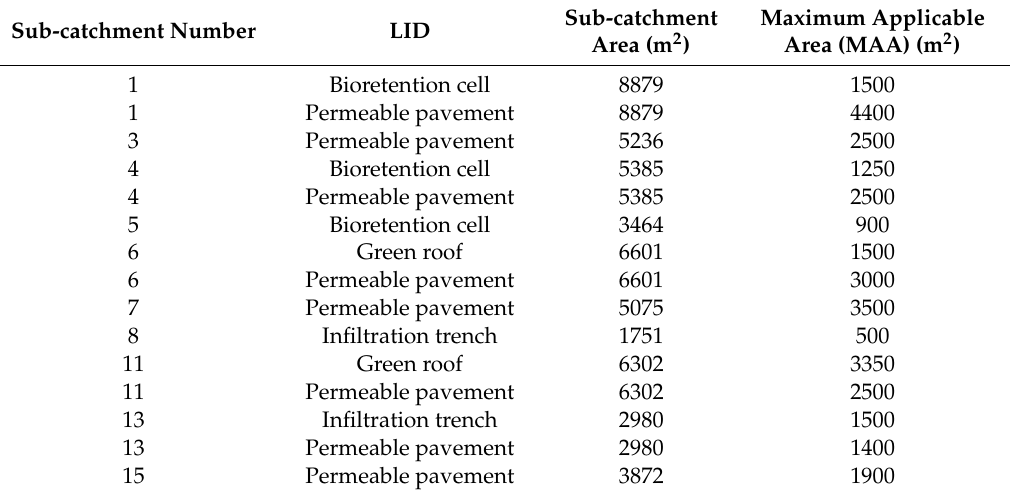
Table 5. LID selection for sub-catchments.